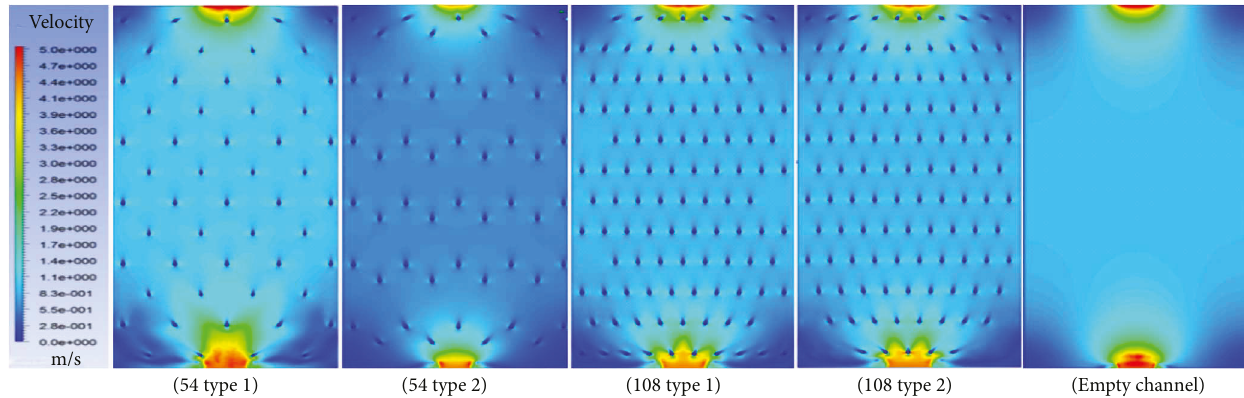
Figure 14: Velocity contours at 4.5m/s.